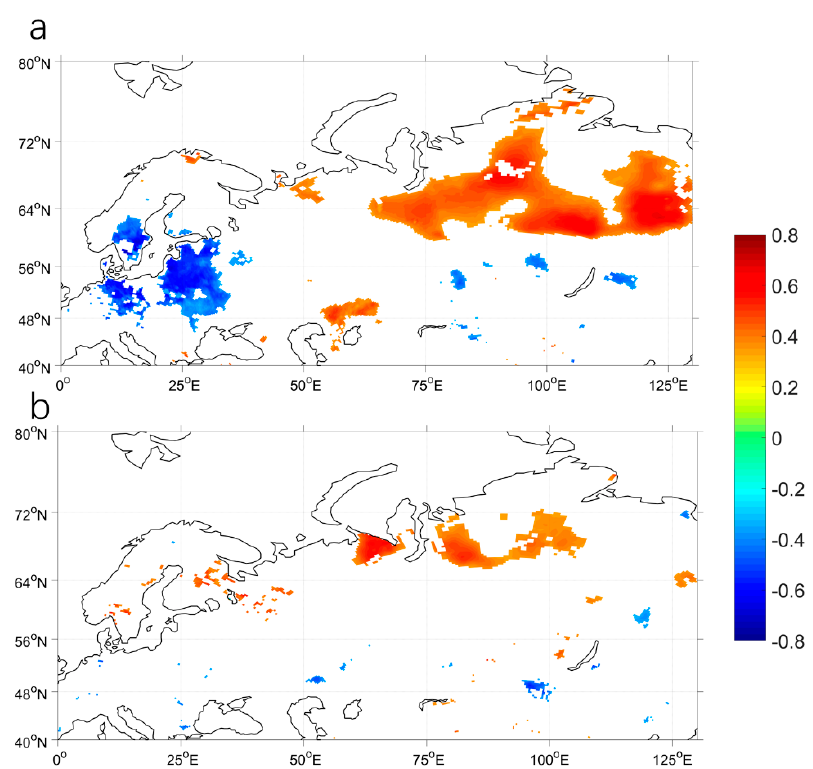
Figure 9. ( a ) The correlation coefficient distribution between the winter Arctic Oscillation and Eurasian winter snow water equivalent; ( b ) the partial correlation coefficient between the Barents– Karas sea ice concentration index and Eurasian winter snow water equivalent. The colored regions passed the t-test with a confidence level of 95%. All of the series have been detrended.